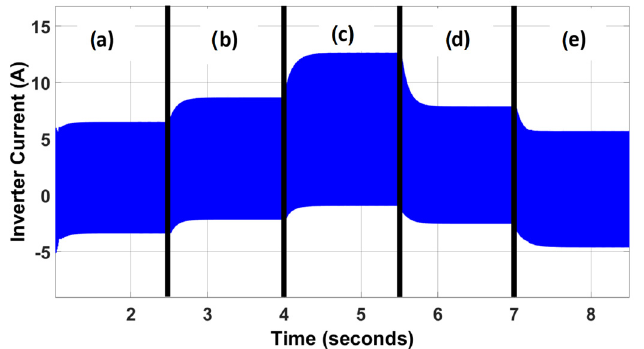
Figure 4. Inverter current, varying torque: (a) at 30% of rated torque; (b) at 60% of non-minimum torque; (c) at full load; (d) at 50% of rated torque; and (e) at 10% of rated torque.